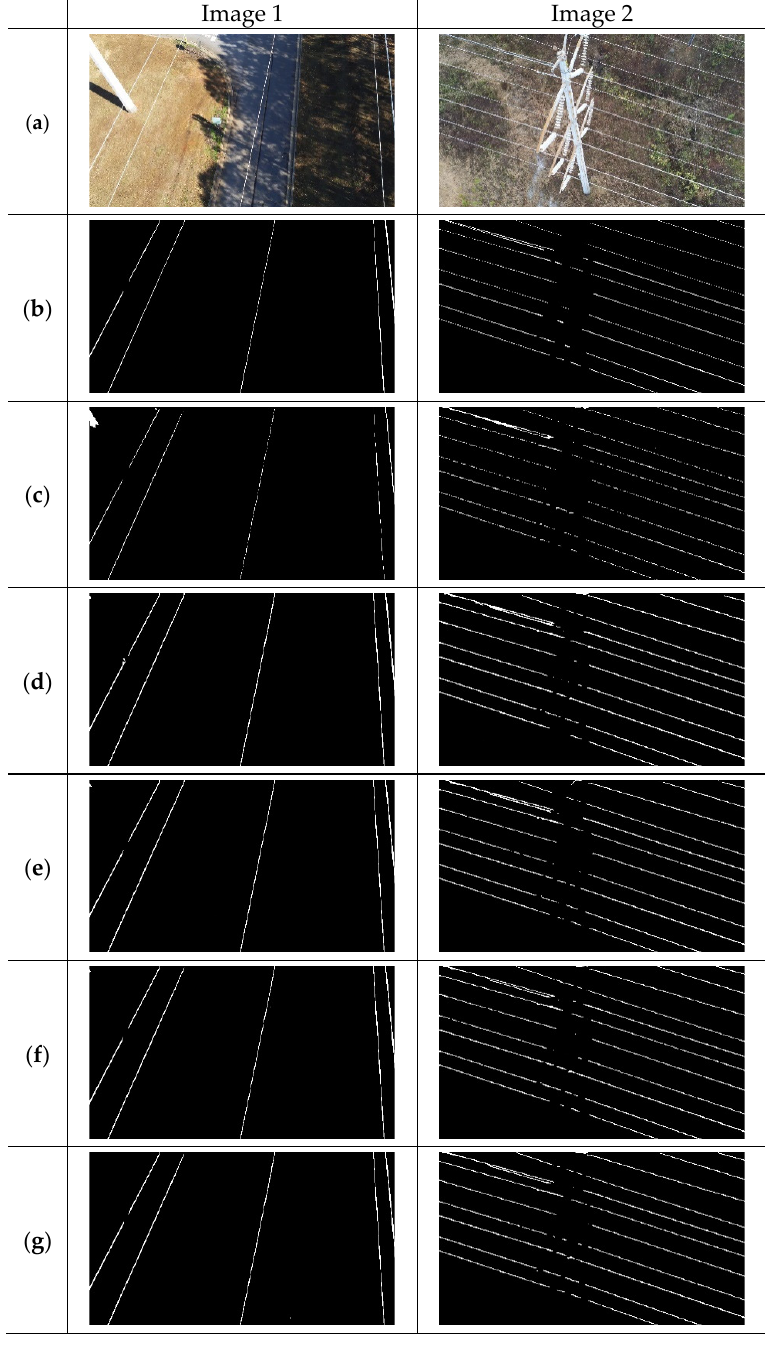
Figure 9. Power line segmentation comparison chart. ( a ) Input image; ( b ) Ground truth; ( c ) Y-UNet; ( d ) Improvement 1; ( e ) Improvement 2; ( f ) Improvement 3; ( g ) G-UNets.